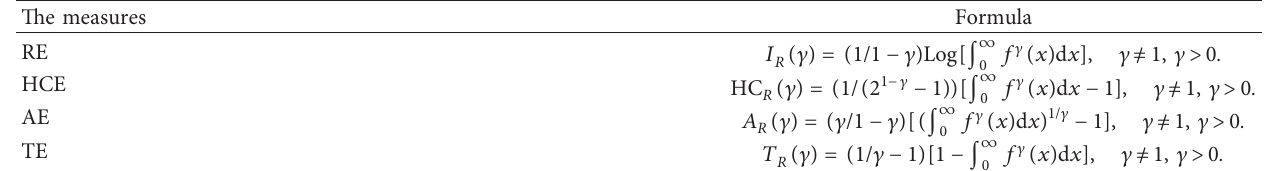
Table 1: Various measures of entropy for a distribution with PDF f ( x ) at c .